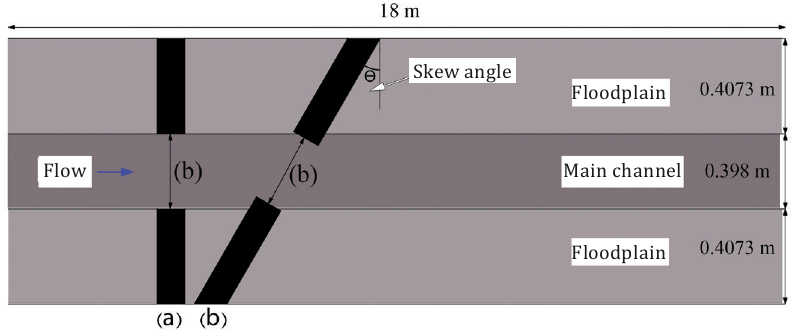
Figure 6. Plan view of Seckin’s (2007) laboratory channel Note: (a) − common crossing and (b) − skewed bridge (skew angle = 30°).